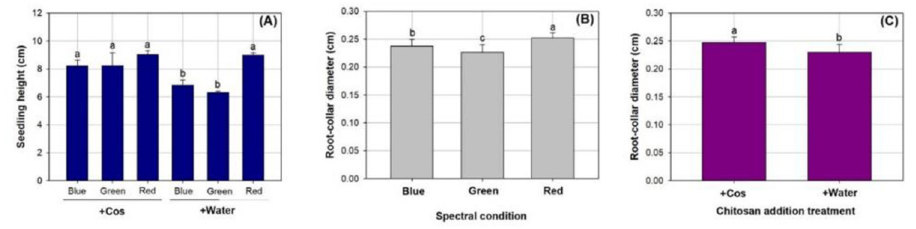
Fig 2. Shoot height (A) and root-collar diameter (B and C) in Podocarpus macrophyllus seedlings exposed to chitosan (+Cos) or water (+Water) sprays in three types of light emitting diodes spectra in red, green, and blue lights. Bar height corresponds to the mean of the measurement while the error bars represent standard errors. Different letters represent difference at significant level of 0.05 by Tukey test.